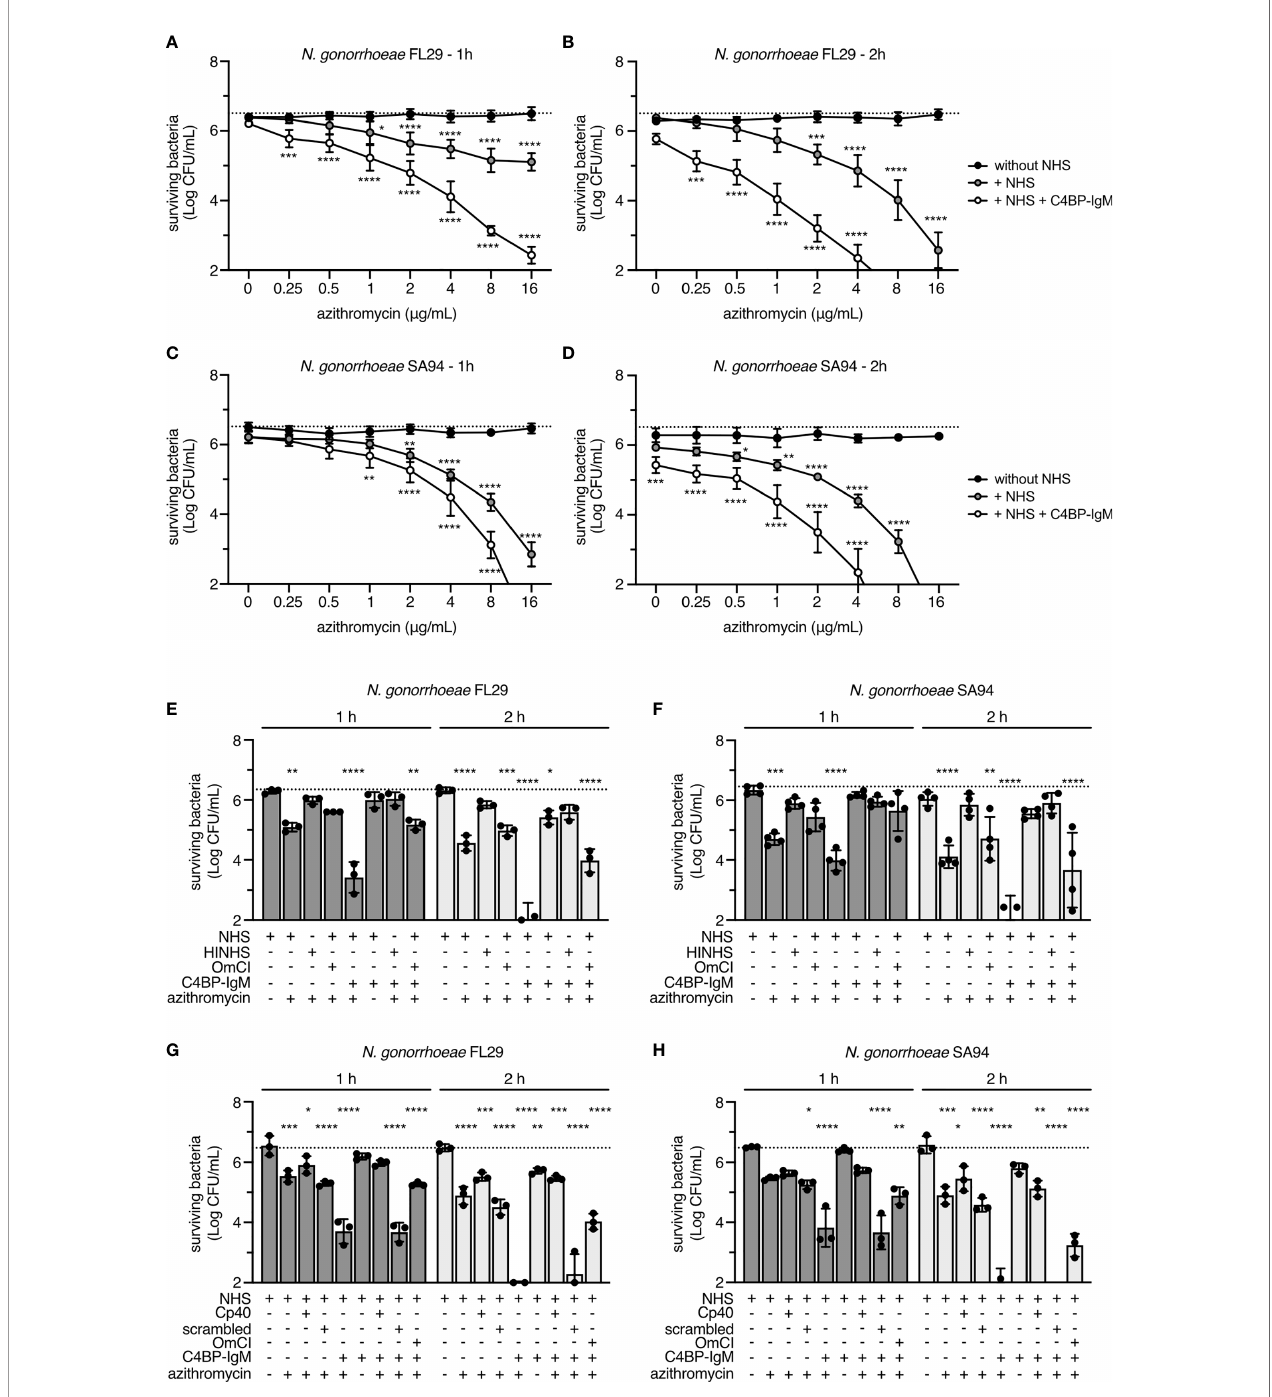
FIGURE 5 | Complement activation in NHS cooperates with antibiotics in killing two azithromycin-resistant strains of N. gonorrhoeae . FL29 (A, B) and SA94 (C, D) gonococci were incubated for 1 and 2 hours with increasing concentrations of azithromycin in the presence or in the absence of 10% NHS and 0.6 m g/mL or 0.16 m g/mL of C4BP-IgM, respectively. At each azithromycin concentration, differences from samples without NHS were compared using two-way ANOVA with Dunnett´s multiple comparison test. FL29 (E, G) and SA94 (F, H) gonococci were incubated for 1 or 2 hours with 10% NHS, HINHS or NHS+OmCI or NHS+Cp40 (50 m M) supplemented with 4 m g/mL of azithromycin, in the presence or in the absence of 0.6 m g/mL or 0.16 m g/mL of C4BP-IgM, respectively. Scrambled peptide is used as irrelevant protein for Cp40-treated samples. Two-way ANOVA with Dunnett´s multiple comparison test was performed considering NHS as reference. Bars display mean+/-SD, with circles indicating 4 (A – D, F) and 3 (E, G, H) independent repeats. In all graphs horizontal dotted line refers to the starting number of bacteria used in the assay. *p < 0.05, **p < 0.01, ***p < 0.005, ****p <